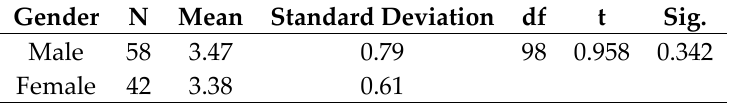
Table 4. Comparison mean between Public awareness and